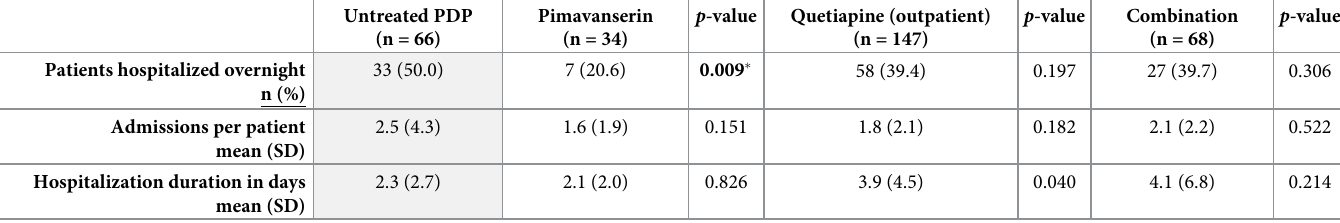
Table 2. Comparison of hospitalization data between Parkinson disease psychosis (PDP) group not receiving antipsychotics (untreated) and PDP groups treated with pimavanserin, quetiapine, or combination pimavanserin and quetiapine.